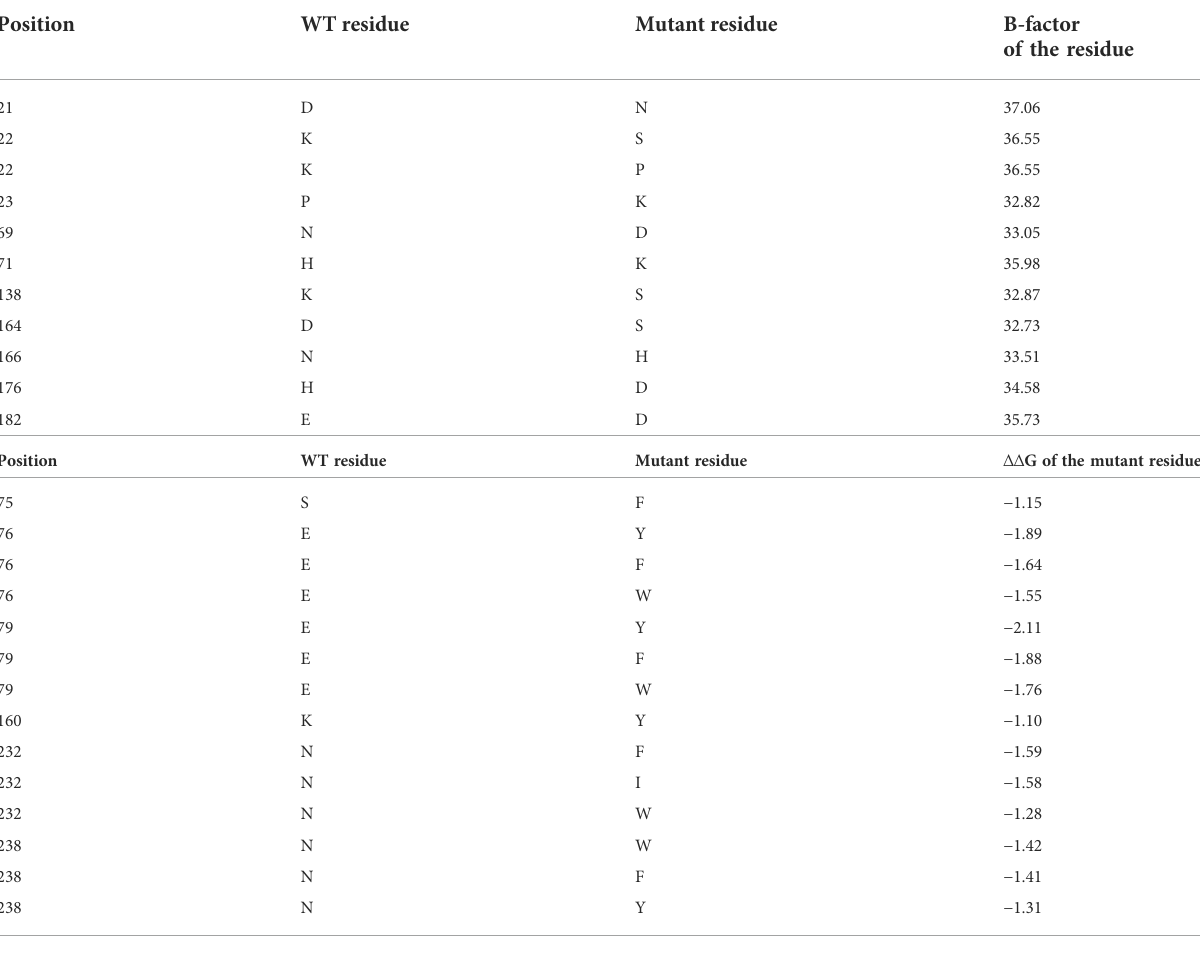
TABLE 1 The target residues predicted using HotSpot Wizard 3.0 and dezyme web servers.